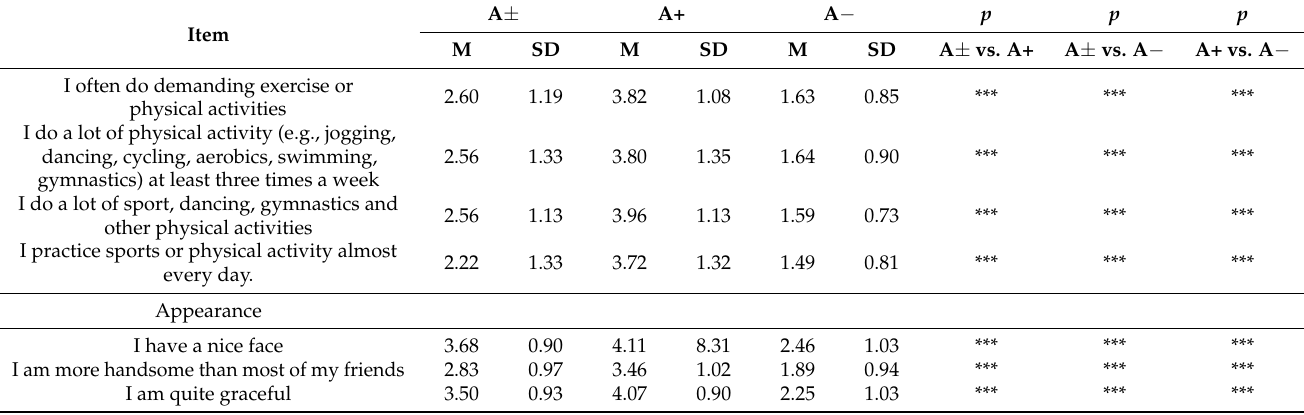
Table 2. Mean physical self-concept